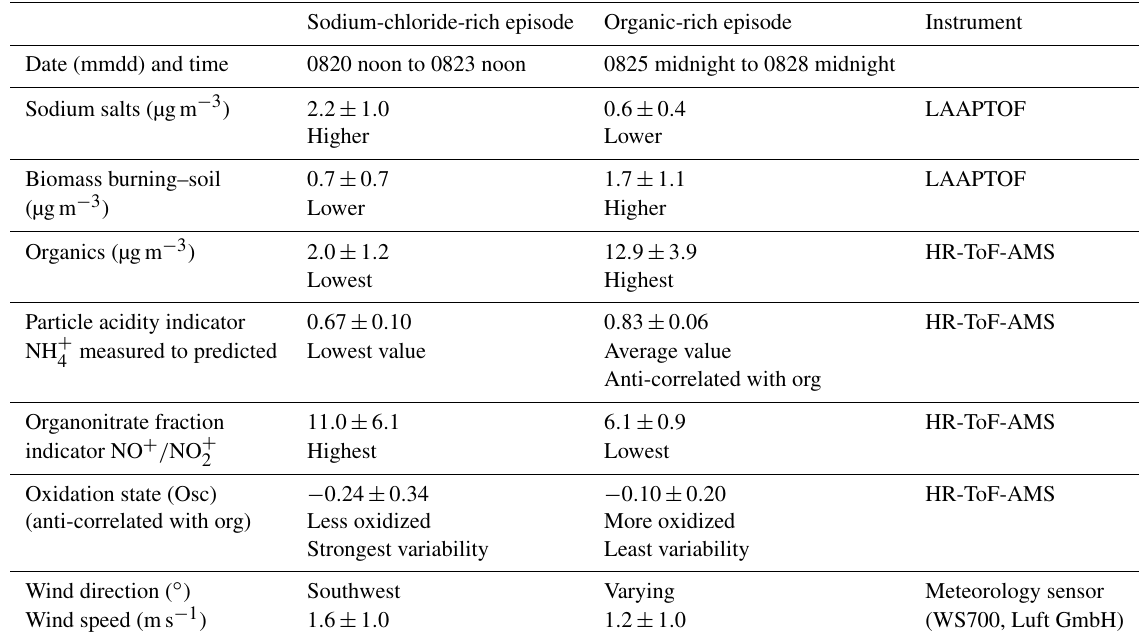
Table 2. Features and mean values ( ± SD) of characteristic parameters for the two selected